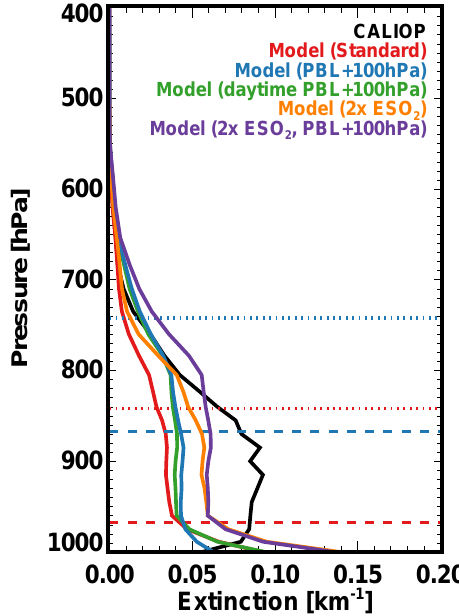
Fig. 6. Aerosol extinction profiles over the SEUS for JJA 2009 as observed by CALIOP (black) and as simulated by GEOS-Chem with original PBL heights (red), PBL heights raised by 100hPa at all hours (blue), raised by 100hPa during daytime hours (green), doubled SO 2 emissions (orange), and doubled SO 2 emissions and PBL heights raised during daytime hours (purple). Average PBL heights are shown in red for original simulation and blue for simu- lations with raised PBL heights, with dashed lines for nighttime and dotted lines for